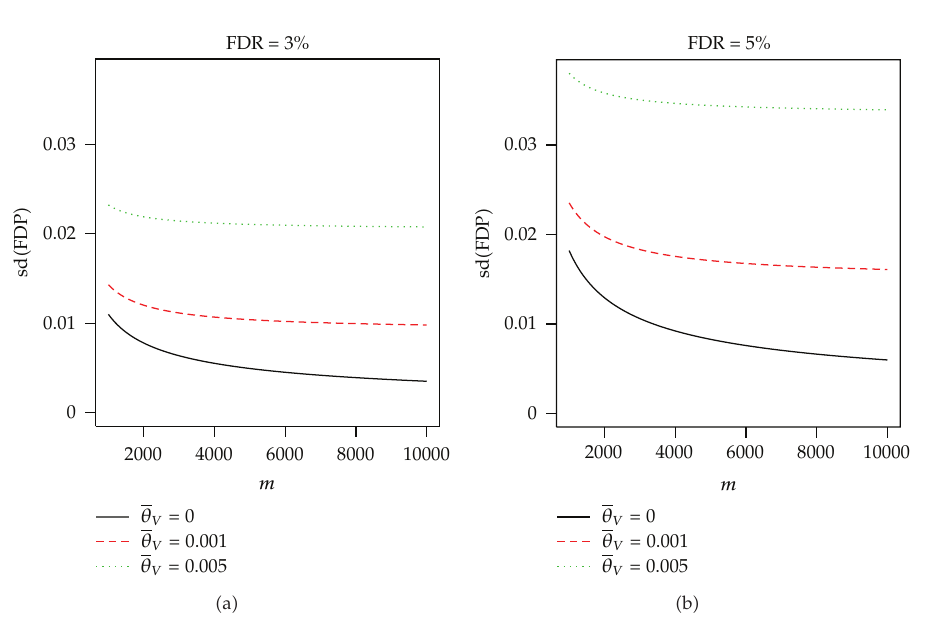
Figure 1: Plots of sd (cid:2) FDP (cid:3) at di ff erent m and θ V . π 0 (cid:8) 0.7, α (cid:8) 0 . 01, θ U (cid:8) 0.001 and θ UV (cid:8) 0. (cid:2) a (cid:3) β (cid:8) 0 . 25, FDR (cid:8) 3%; (cid:2) b (cid:3) β (cid:8) 0 . 56, FDR (cid:8) 5%.